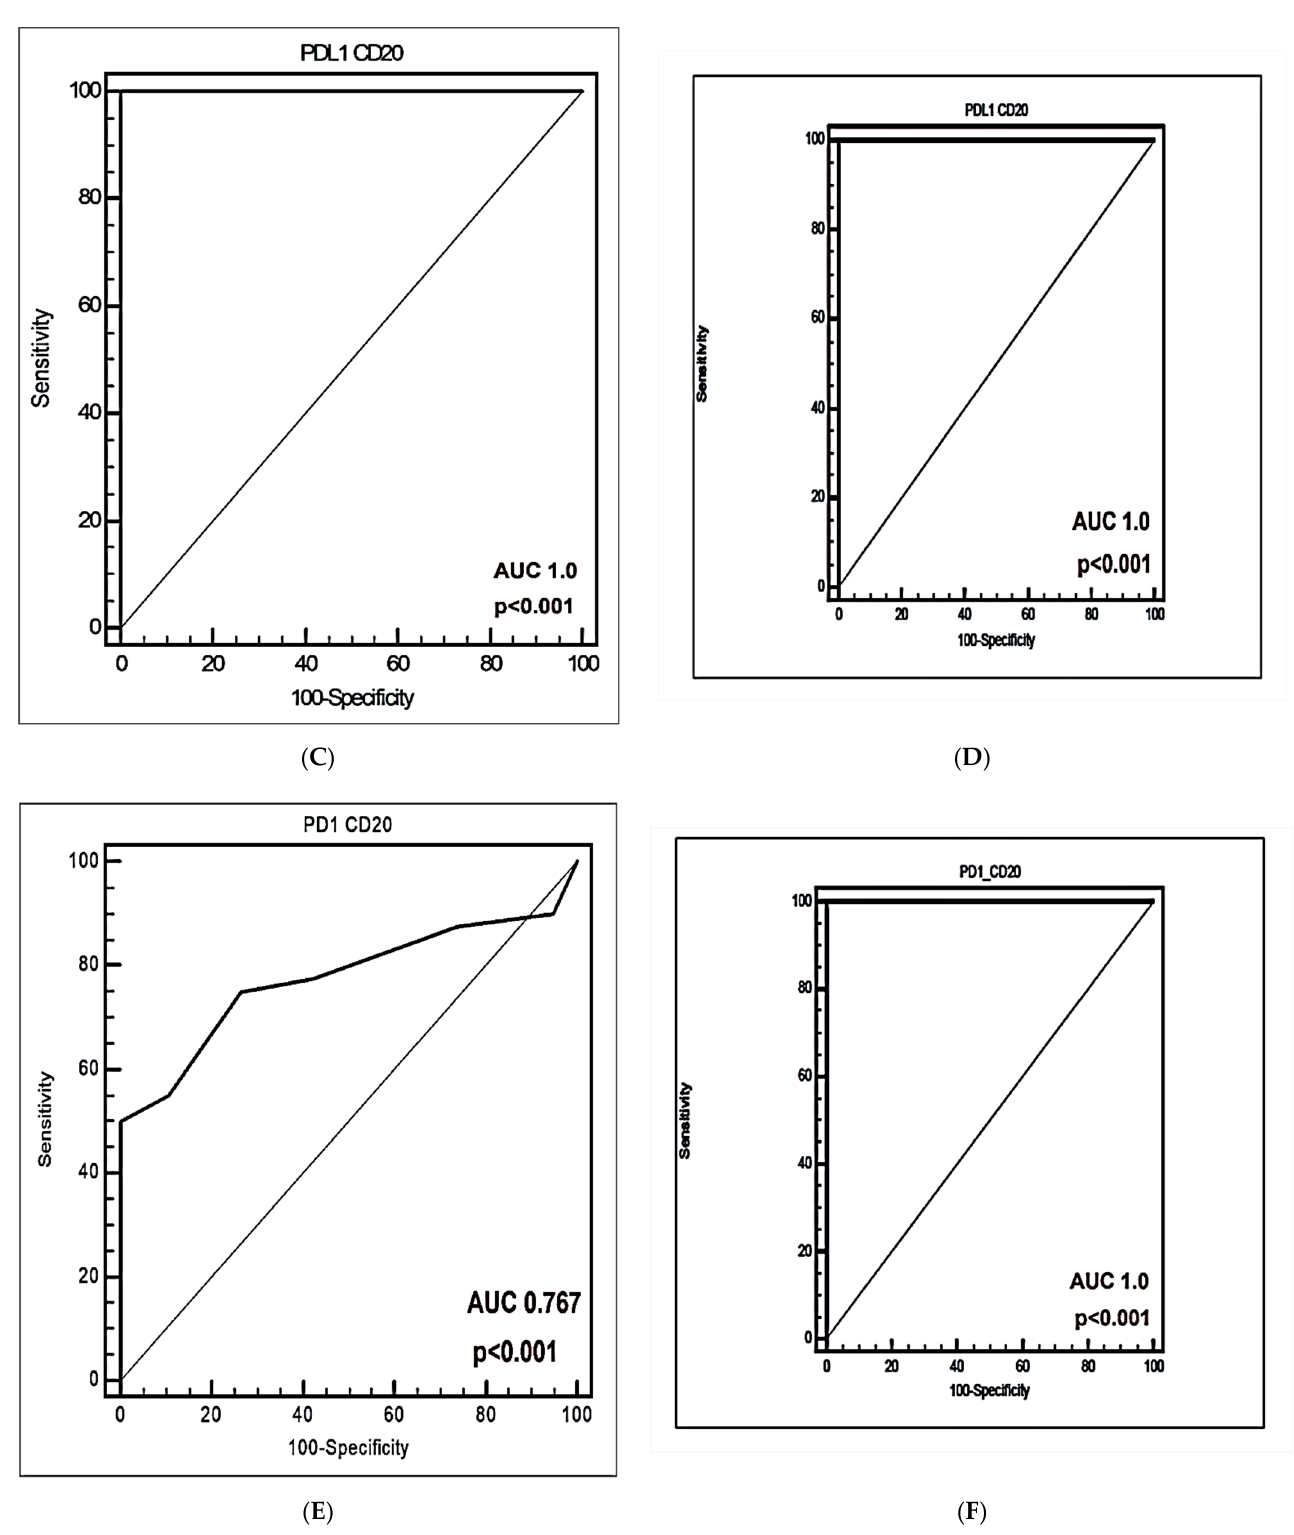
Figure 5. Receiver operating characteristic (ROC) curve performance for prediction and diagnosis of DLBCL. ( A , B ) ROC curves of percentages of CD20+ cells. ( C , D ) ROC curves of percentages of PD-L1+CD20+ cells. ( E , F ) ROC curves of percentages of PD-1+CD20+ cells (%).